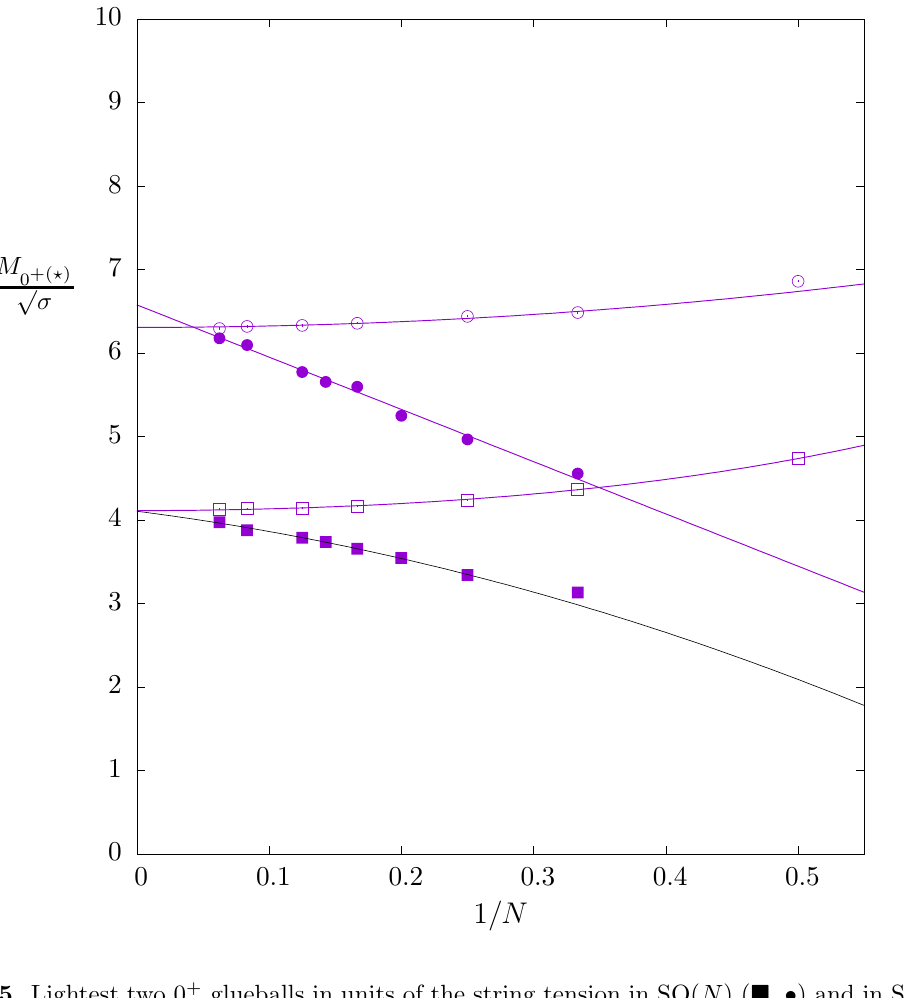
Figure 25 . Lightest two 0 + glueballs in units of the string tension in SO( N ) ( (cid:4) , (cid:15) ) and in SU( N ) ( (cid:3) , (cid:14) ) with typical extrapolations to N = 1